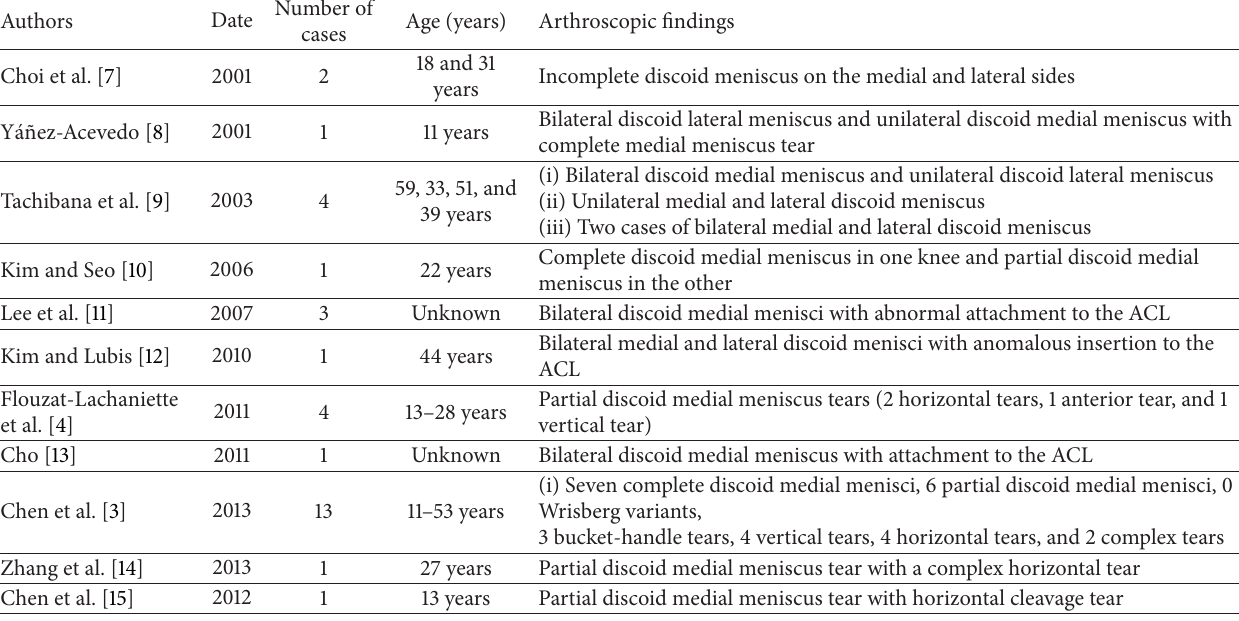
Figure5: (a)Axial viewdiagram drawingdisplaying themother’s superficialtear. (b)Sagittal viewdiagram drawing ofthemother’shorizontal meniscal tear. Table 1: Reports of discoid medial meniscus since